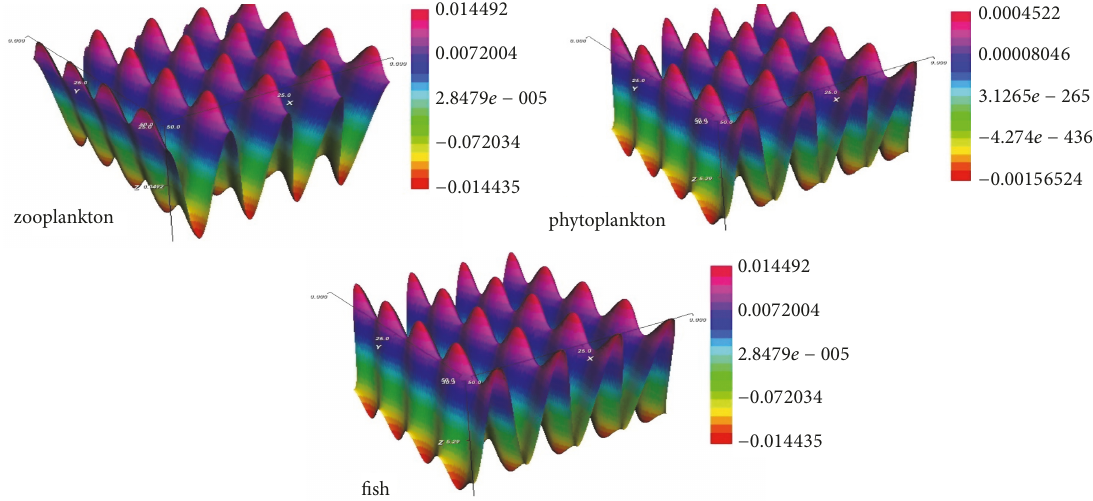
Figure 9: Dynamics behavior for 𝜃 𝑝 = 0.29 .